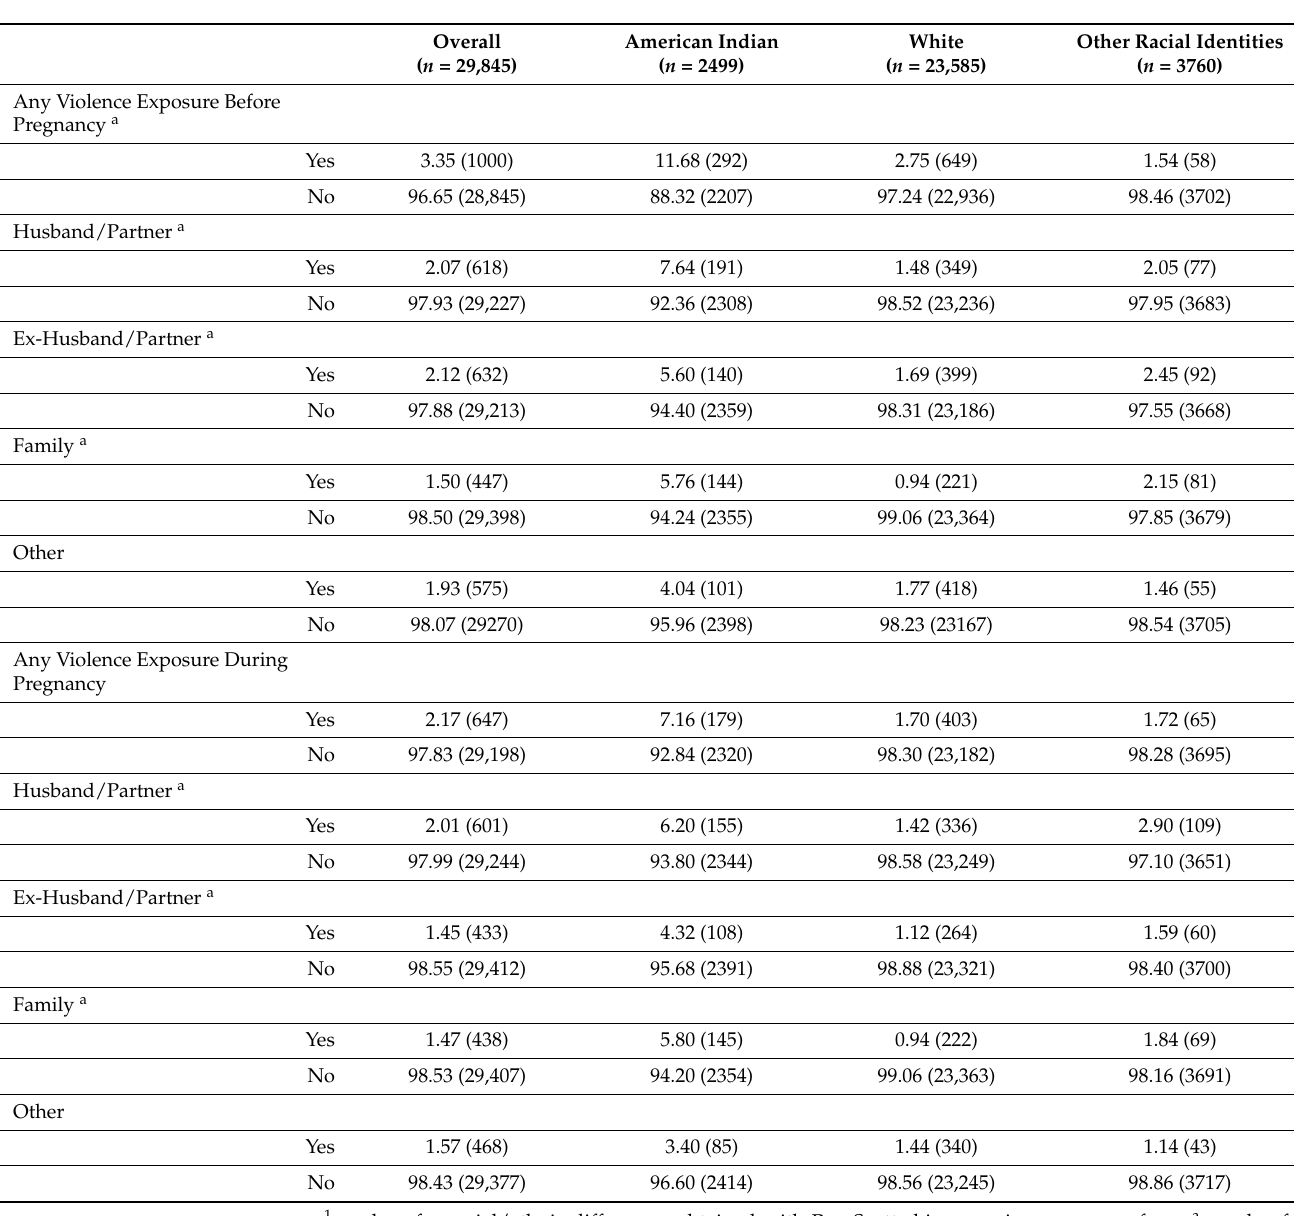
Table 2. Weighted Relative (and absolute) frequency of violence exposure by race/ethnicity in ND PRAMS 1 . Overall American Indian ( n = 29,845) ( n = 2499)